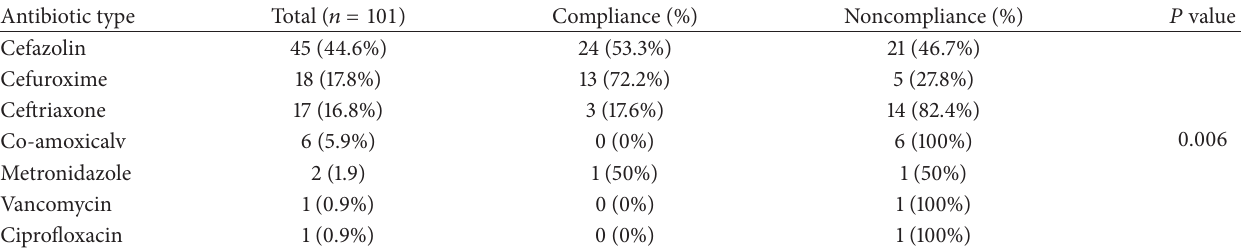
Table 3: Association between different antibiotic types and compliance with hospital